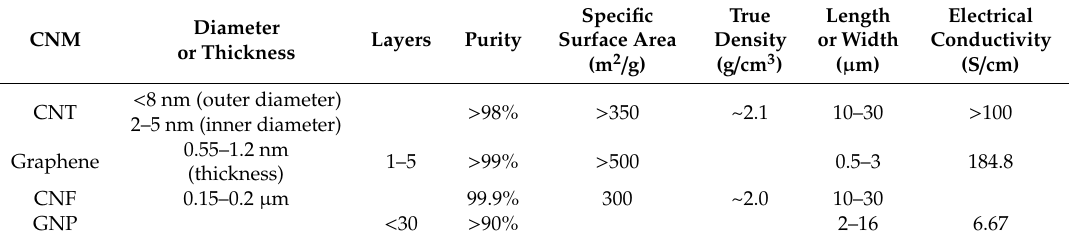
Table 1. Physical properties and dimensions of the carbon